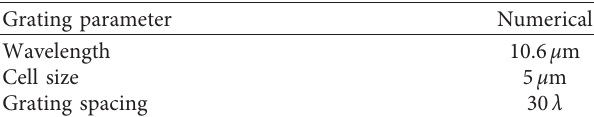
Table 5: Physical parameters of neural network grating.